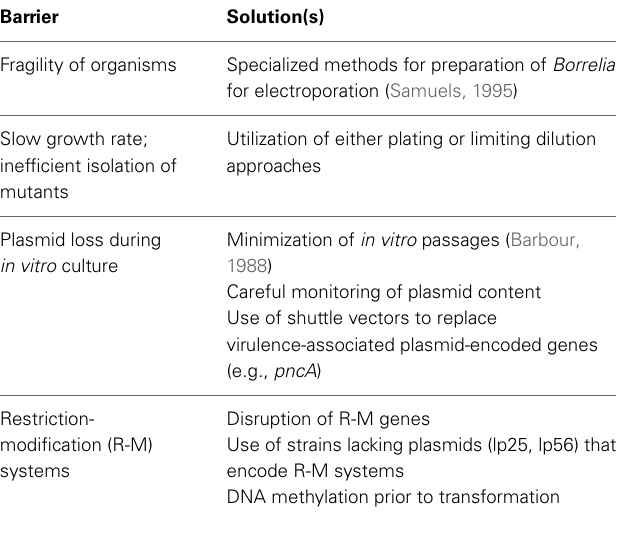
Table 1 | Challenges to genetic manipulation of Borrelia species.